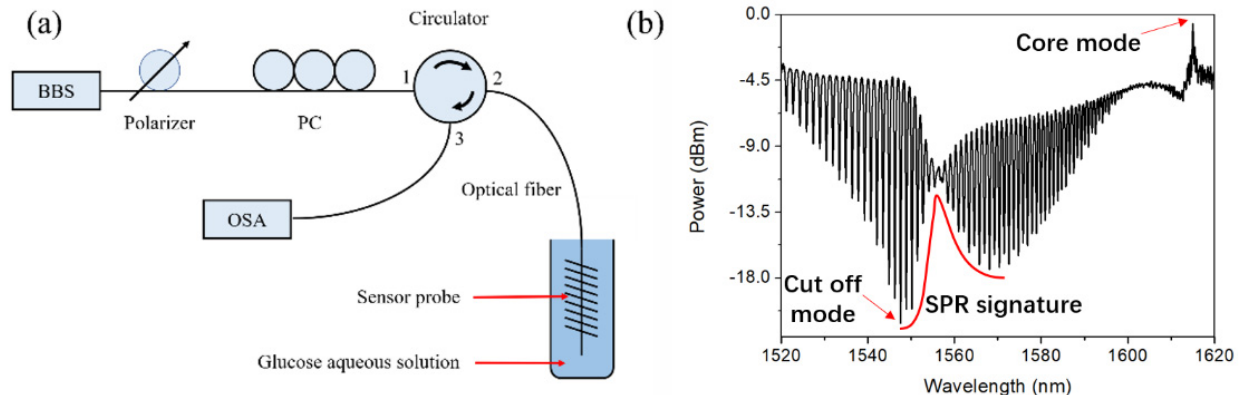
Figure 1. ( a ) Schematic set-up of the TFBG-SPR sensor probe for the SRI measurement in glucose aqueous solutions, and 1, 2 and 3 represent the port number of the circulator; ( b ) P-polarized reflected spectrum of the TFBG-SPR sensor probe in the glucose aqueous solution with a SRI of ~1.3573.